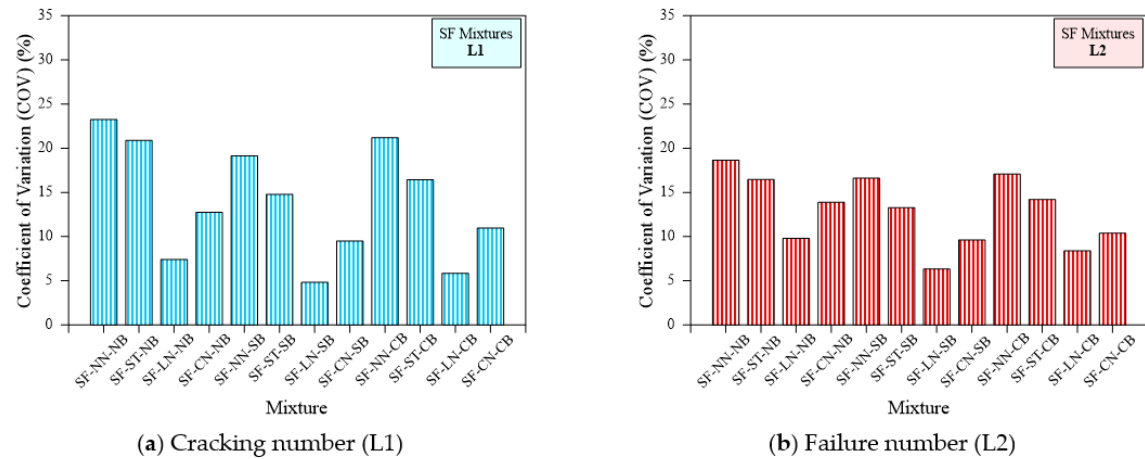
Figure 21. Coefficient of variation of cracking and failure impact numbers of SF